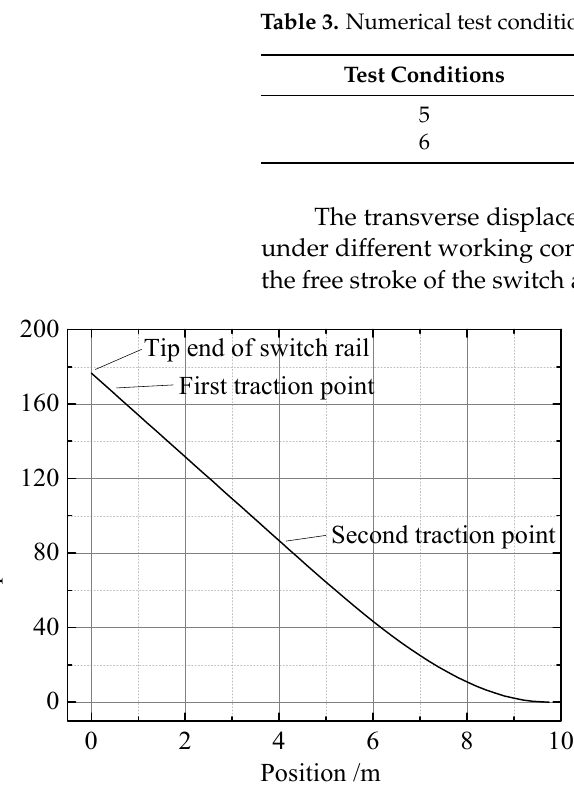
Table 3. Numerical test conditions.